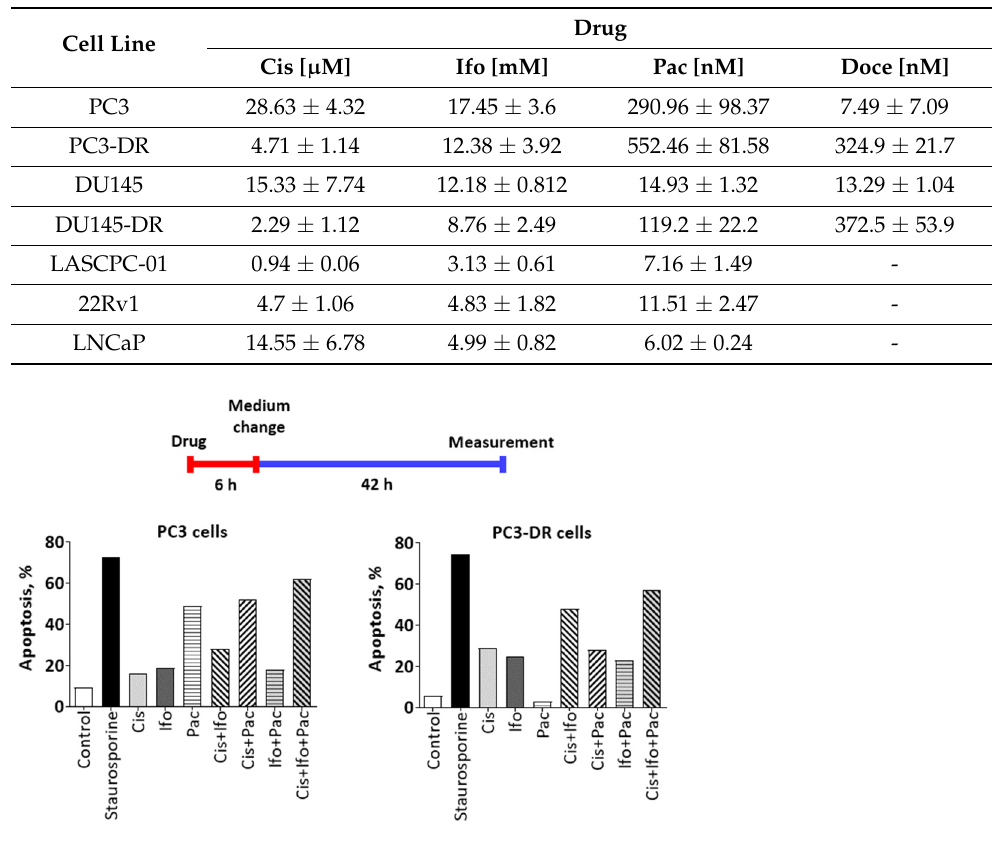
Figure 2. Effect of the drugs on caspase activity. Upper panel: Schematic representation for the experiment flow. PC3 or PC3-DR cells were treated with Cis, Ifo, and Pac at concentrations equal to their corresponding IC 50 s either individually or combined. The pan-caspase activity was measured after 48 h using FAMFLICA™ Poly Caspases Assay Kit. Cells treated with 1 µ M staurosporine for 12 h were used as a positive control. Table 3. Cytotoxic activity of the drugs in vitro. IC 50 of cisplatin (Cis), ifosfamide (Ifo), and paclitaxel (Pac) were evaluated in various prostate cancer cell lines following 48 h of treatment using an MTT assay. The data are represented as mean ± standard deviation.